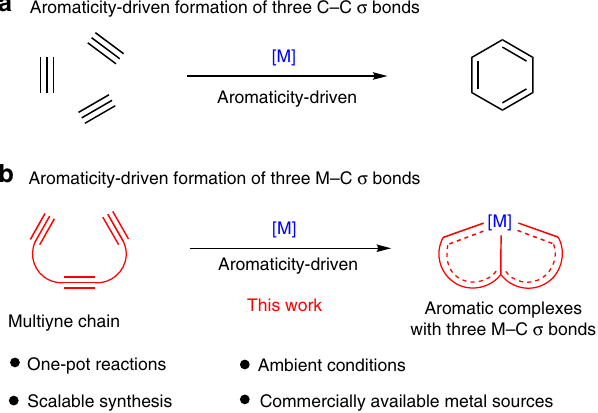
Fig. 1 Ef fi cient synthesis through aromaticity-driven cyclization reactions. a Formation of three C – C σ bonds through an aromaticity-driven process. b Formation of three M – C σ bonds through an aromaticity-driven process.